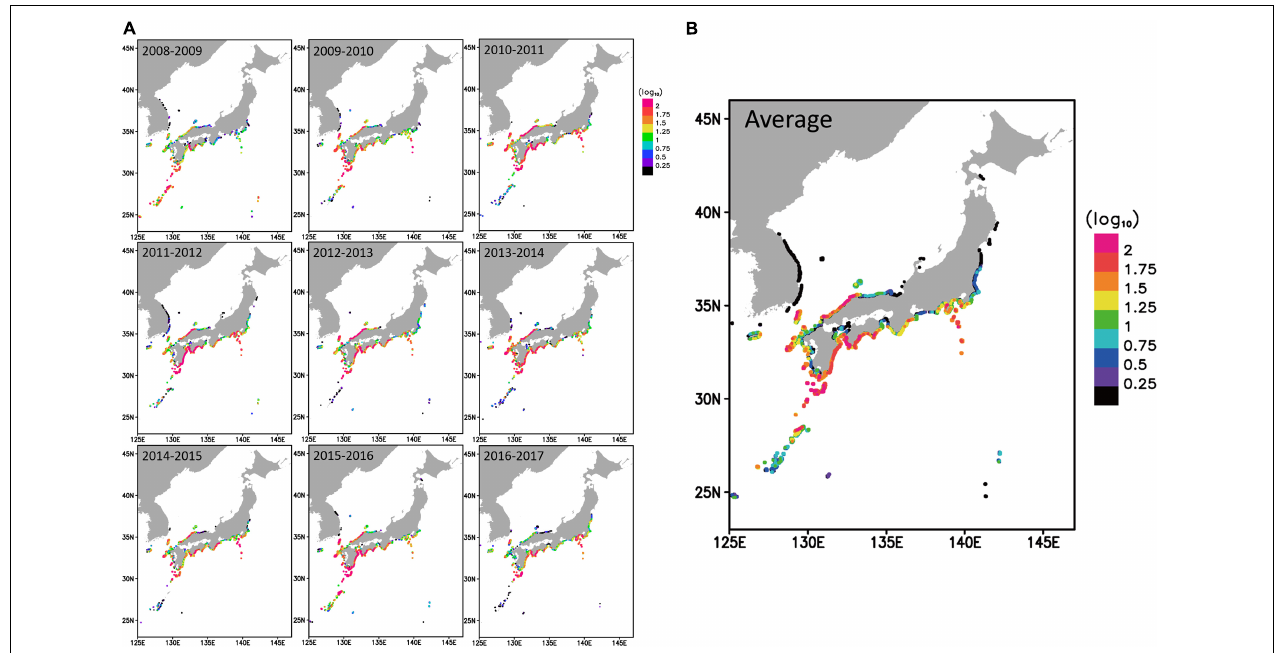
FIGURE 4 | The number of particles that reached each coastal area by April 30 in (A) each year and (B) 9 years average for the period 2008–2017. The number of particles is expressed in color on a log scale. Warm colors indicate more, and cooler colors indicate fewer particles.